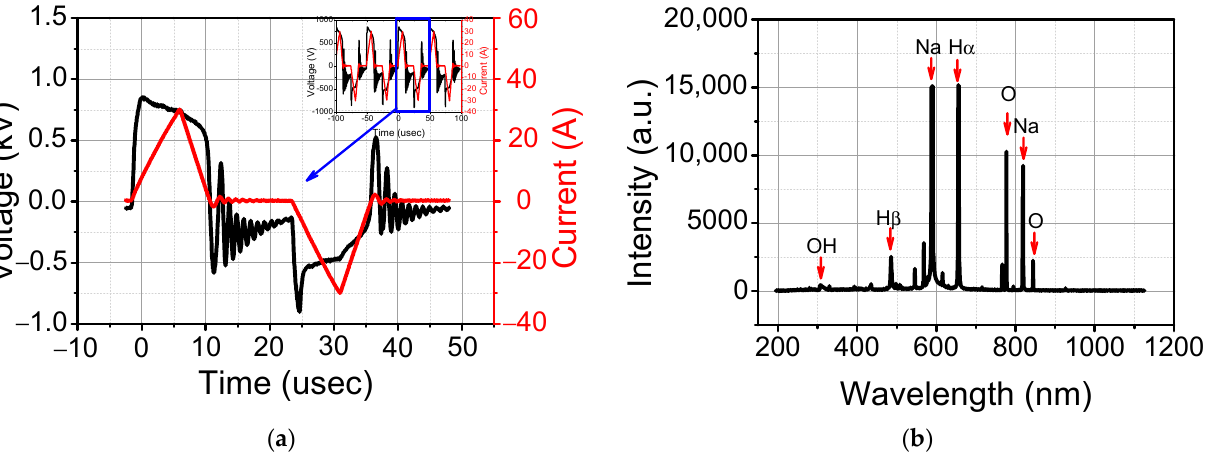
Figure 2. The characteristics of underwater plasma in saline water. ( a ) Voltage and current signals; ( b ) optical emission spectrum (OES) signals.